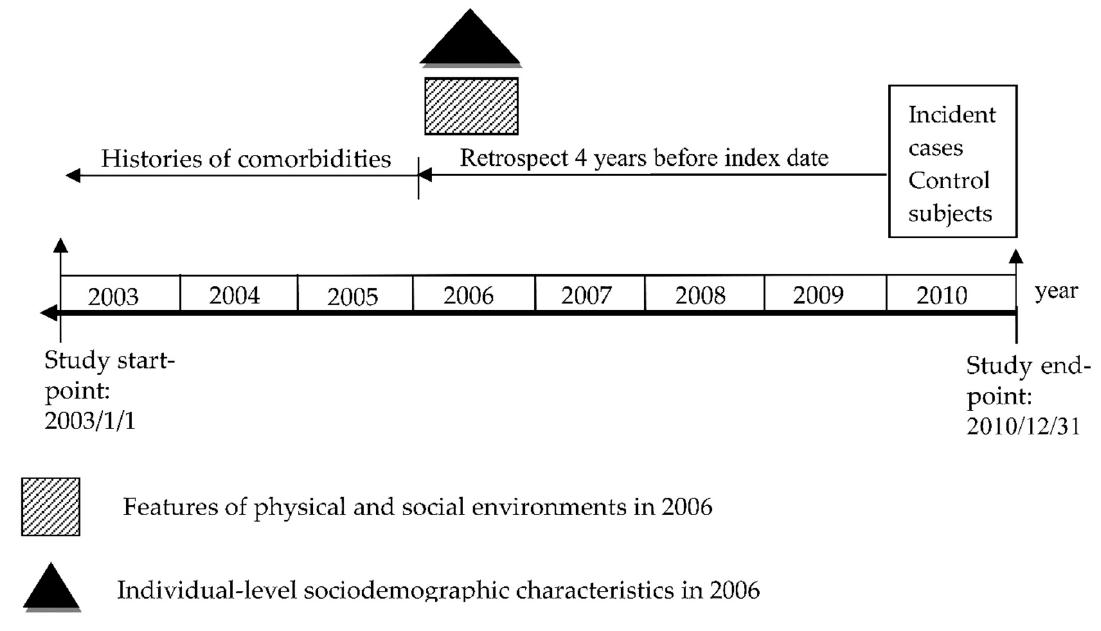
Figure 2. Exposure time for the environmental features in the case and control groups.